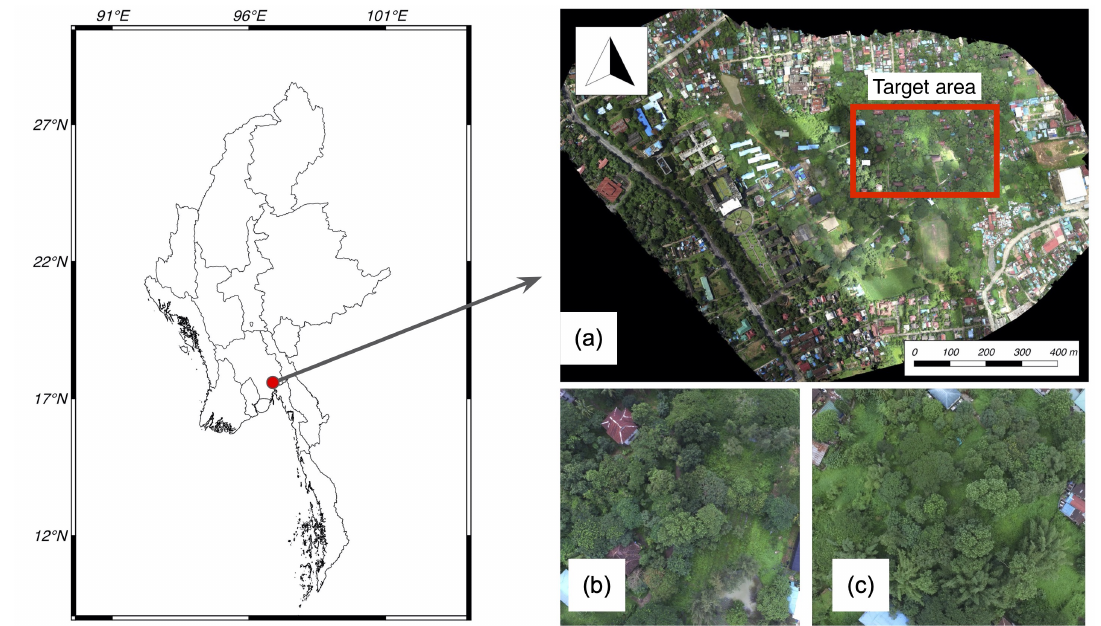
Figure 1. Location of the study area: ( a ) Overall target forest (red rectangular shows the target area of 400 m × 200 m). ( b , c ) Photographs taken by UAV (30 September